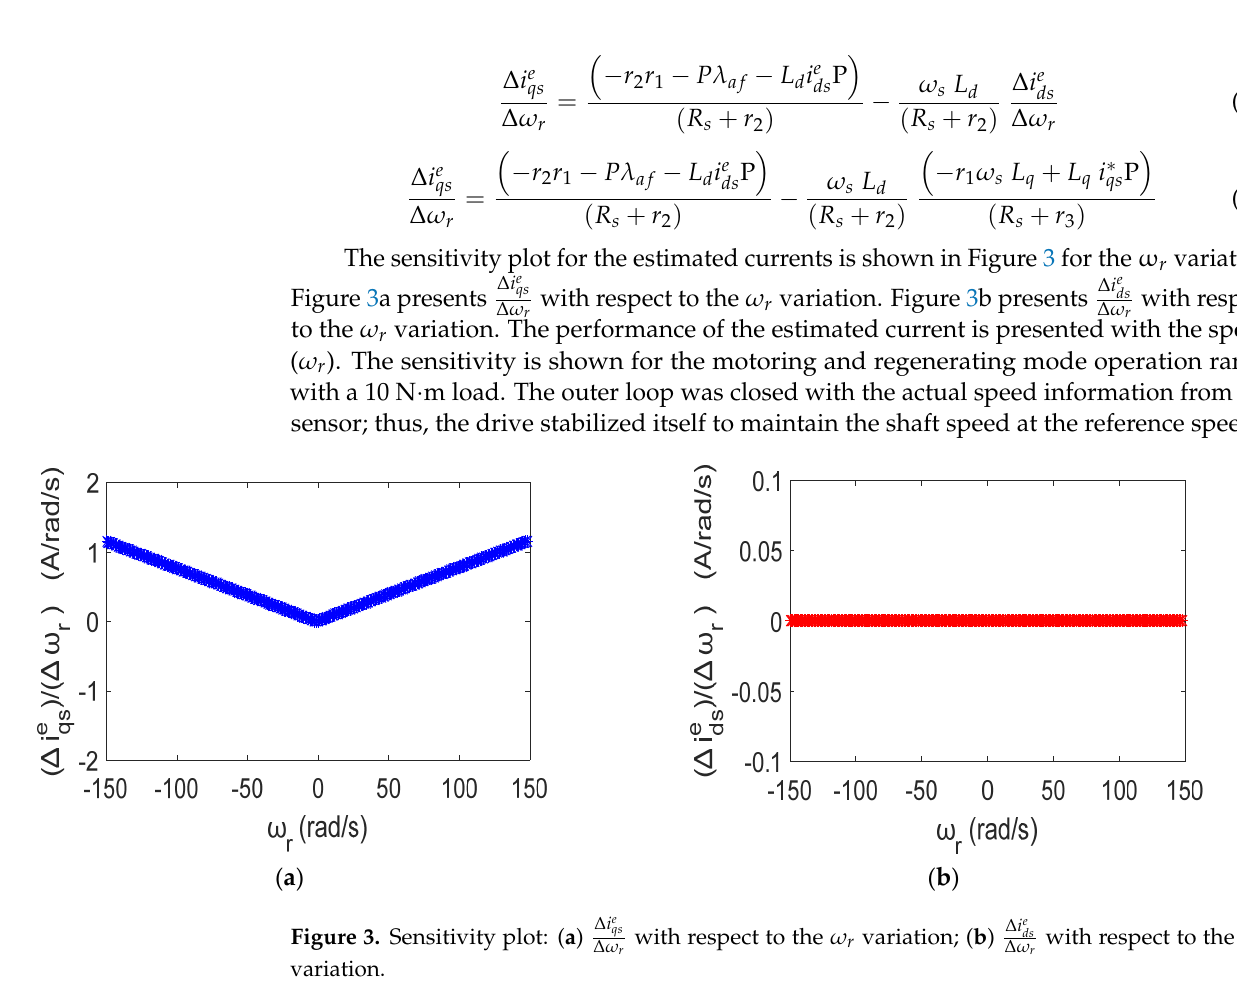
Figure 3. Sensitivity plot: ( a ) ω (cid:2928) variation.